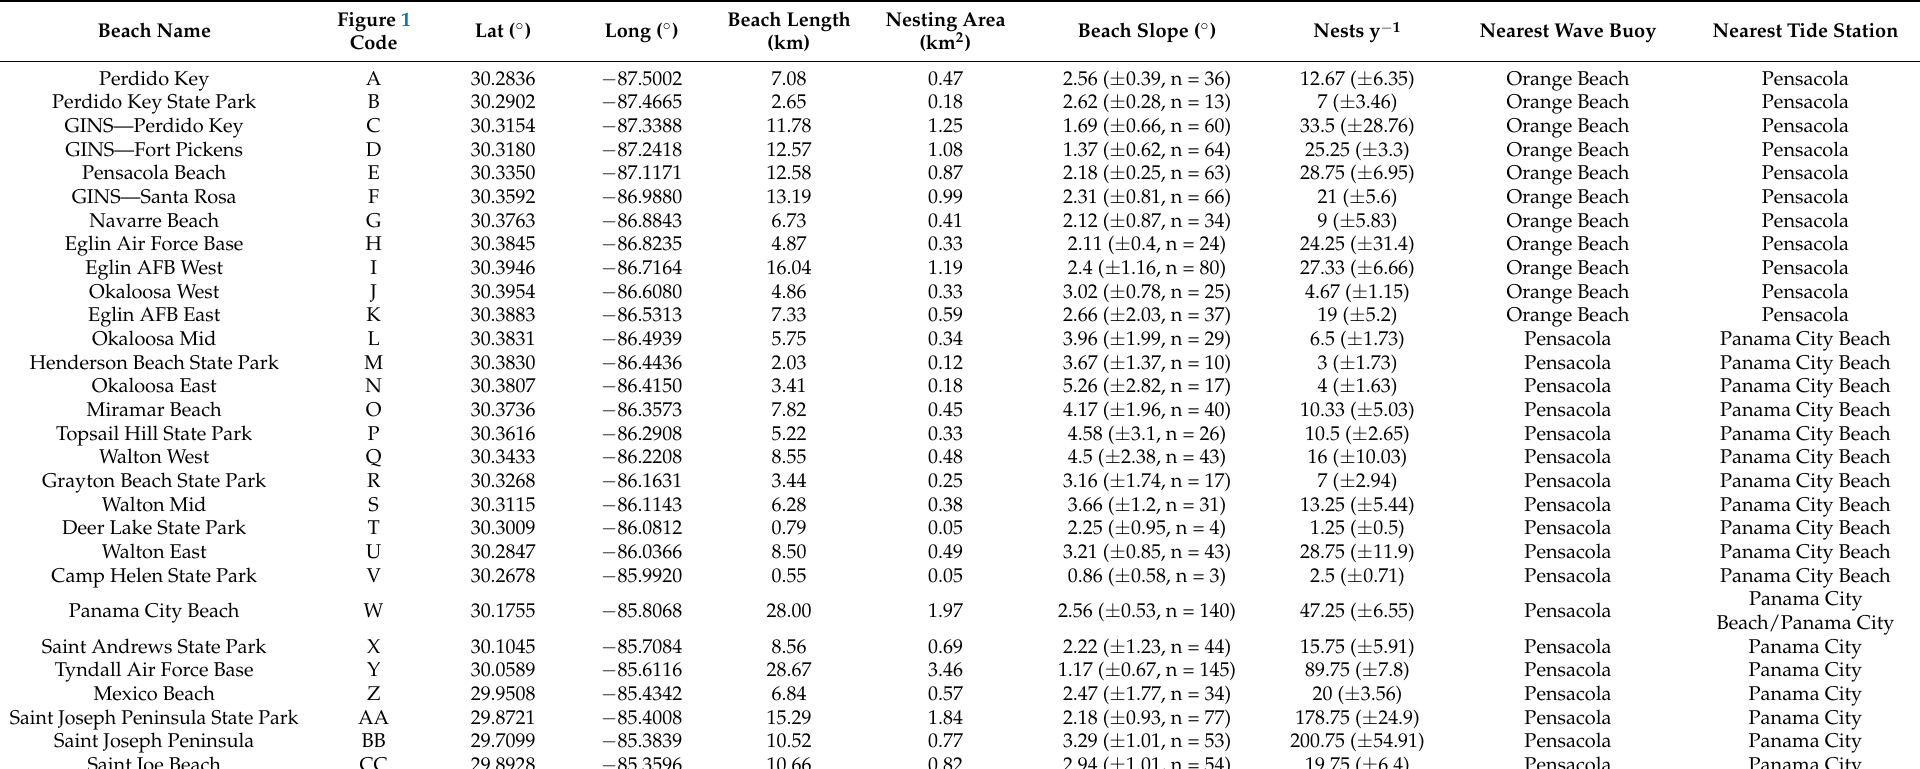
Table 1. Nesting beaches comprising the Florida portion of the Northern Gulf of Mexico Loggerhead Recovery Unit ordered from west to east. Beach slope was taken along cross-shore transects from the shoreline to the base of the dune or back-beach construction every 200 m along the beach digital elevation model. For beach slope and number of nests per year, values are presented as mean ± 1 standard deviation. n indicates number of available transects. Nesting data (2016–2019) was provided by the Florida Fish and Wildlife Conservation Commission Fish and Wildlife Research Institute. Latitude and longitude represent the centroids of the nesting beach. AFB: Air Force Base, GINS: Gulf Islands National Seashore, NWR: National Wildlife Refuge, NA: data was not provided. Additional data is provided in Table